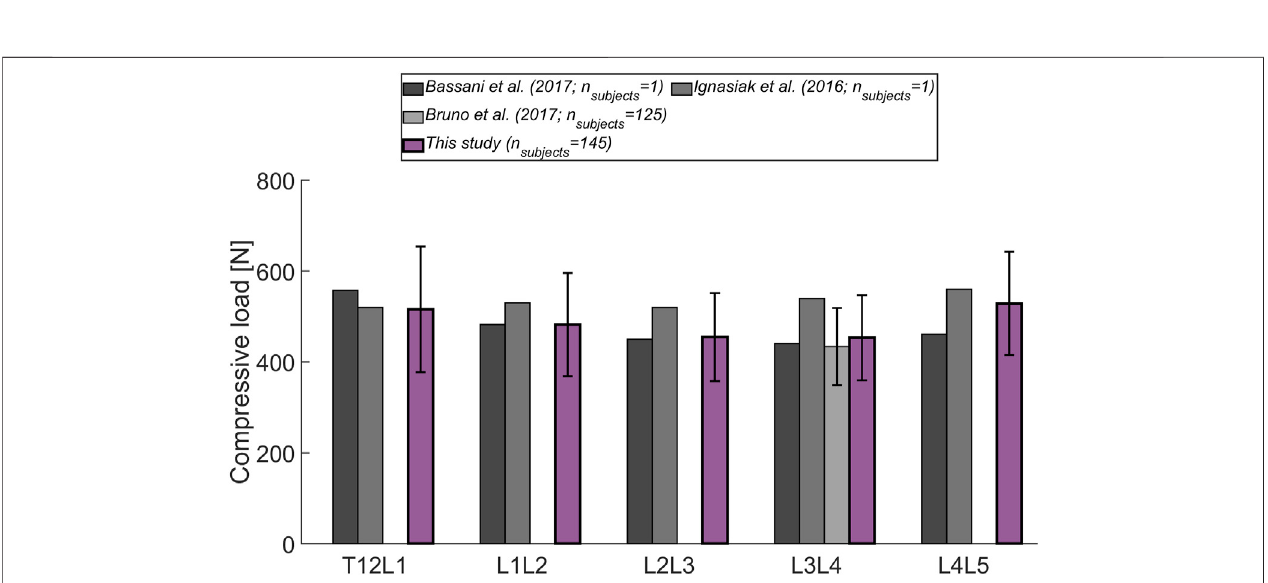
FIGURE 8 | Level-dependent comparison of the magnitude of compressive forces during standing with the outcome from other musculoskeletal models (Bassani et al., 2017; Ignasiak et al., 2016a; Bruno et al., 2017). Error bars indicate the standard deviation.